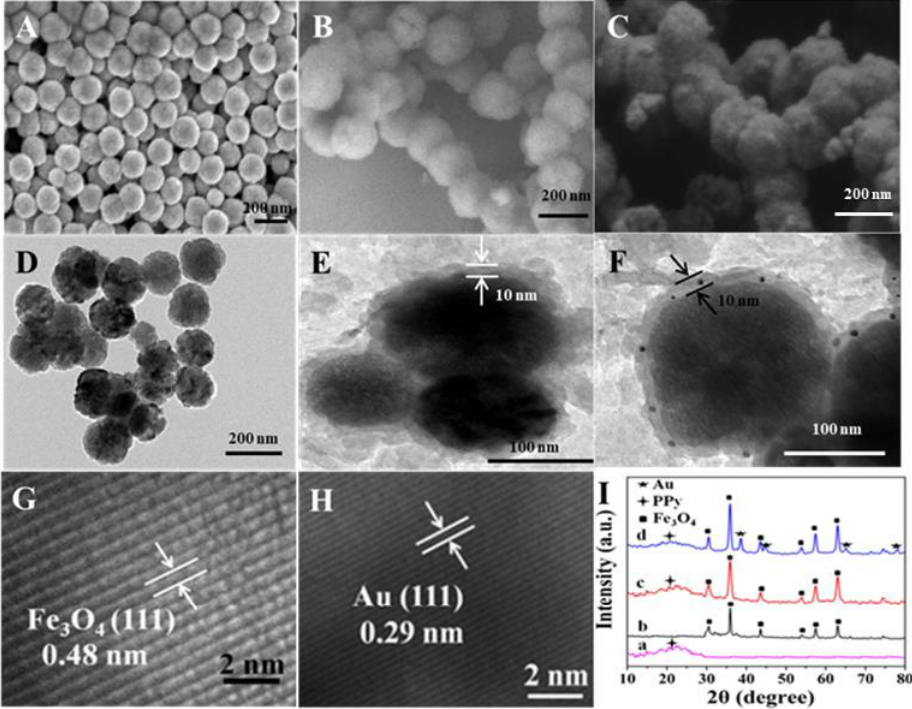
Figure 1. ( A – C ) SEM and ( D – F ) TEM images of ( A , D ) Fe 3 O 4 , ( B , E ) Fe 3 O 4 @PPy and ( C , F ) Fe 3 O 4 @Au/PPy. ( G , H ) HRTEM images of Fe 3 O 4 @Au/PPy nanocomposites. ( I ) XRD patterns of (a) PPy, (b) Fe 3 O 4 , (c) Fe 3 O 4 @PPy and (d) Fe 3 O 4 @Au/PPy. Fe 3 O 4 , PPy and Au diffraction peaks are labeled as “ ■ ” , “ ✦ ” and “ ★ ”, respectively .